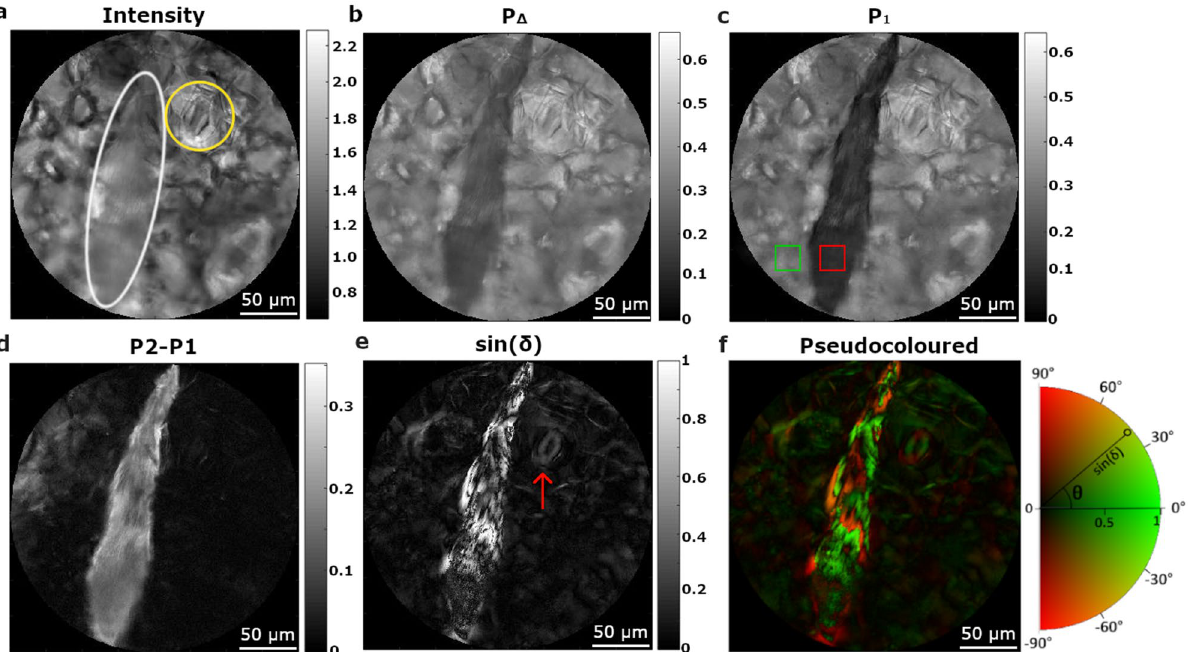
Figure 2. Polarimetric analysis of a small piece of the Epipremnum aureum leaf (marked with a white rectangle in Fig. 1b). Different images of an inulin raphide, situated close to a stoma, are provided, which were obtained by using different channels: ( a ) Intensity; ( b ) P Δ; ( c ) P 1 ; ( d ) P 2 –P 1 ; ( e ) The sinus of linear retardance δ (stoma highlighted with a red arrow); and ( f ) Pseudocoloured image encoding retardance modulus and orientation. Pseudocoloured image comprises the linear retardance of the sample (shown into a white–black scale; radius of the semi-circular colour scale), and the fast axis orientation (represented with different colours; perimeter of the semi-circular colour